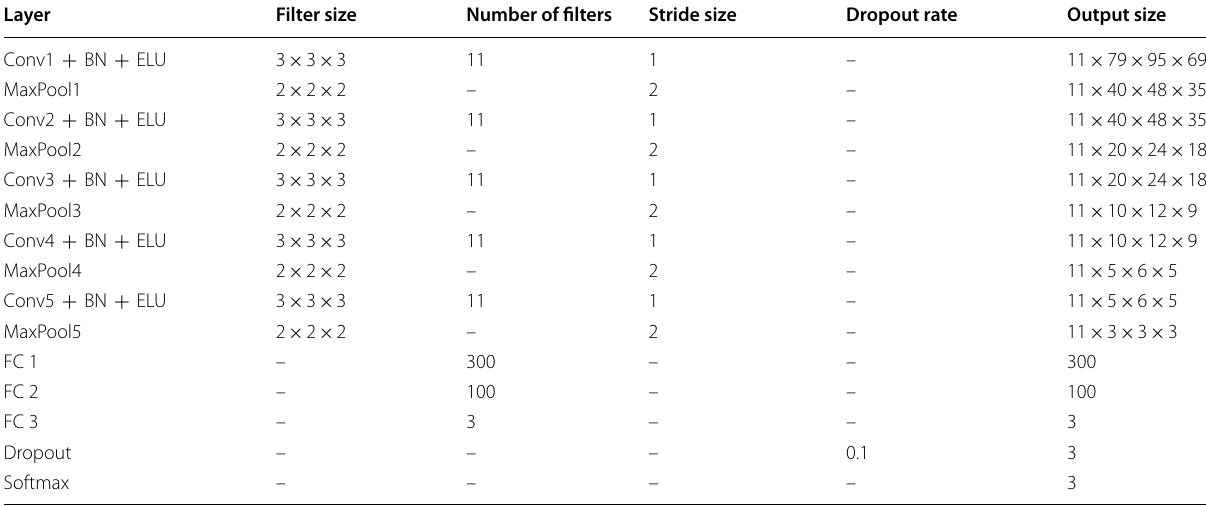
Table 3 Architecture hyperparameters for our proposed 3D‑CNN